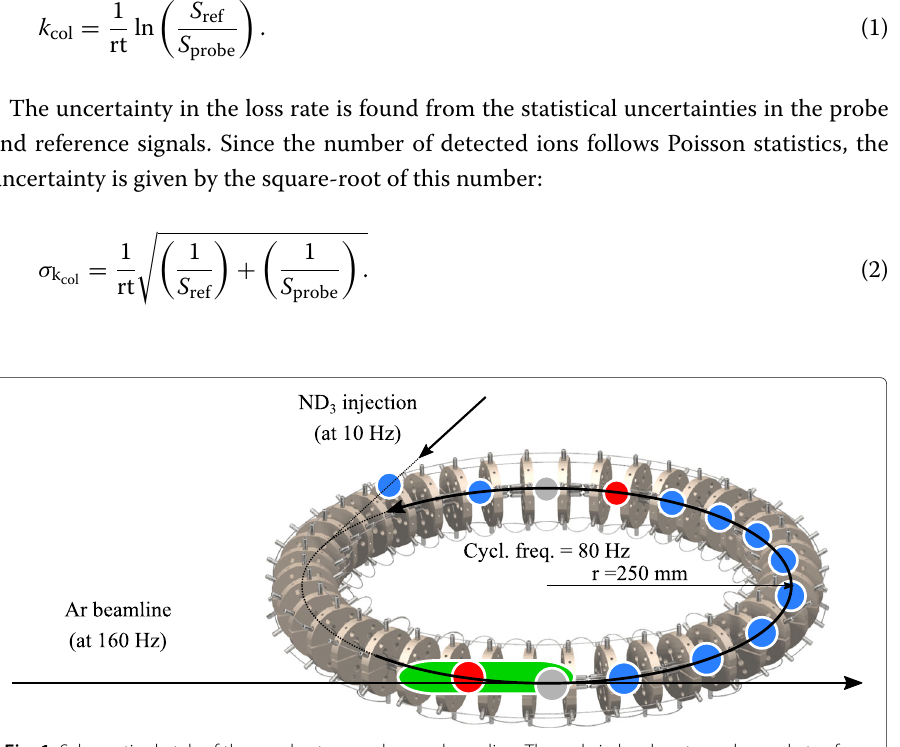
Fig. 1 Schematic sketch of the synchrotron and argon beamline. The red circles denote probe packets of ammonia molecules which are targeted by the argon beam (shown in green). The blue circles denote reference packets of ammonia, which do not encounter argon atoms and provide a simultaneous background measurement. The grey circles denote reference packets of ammonia that encounter the leading or trailing end of the argon beams, and are therefore